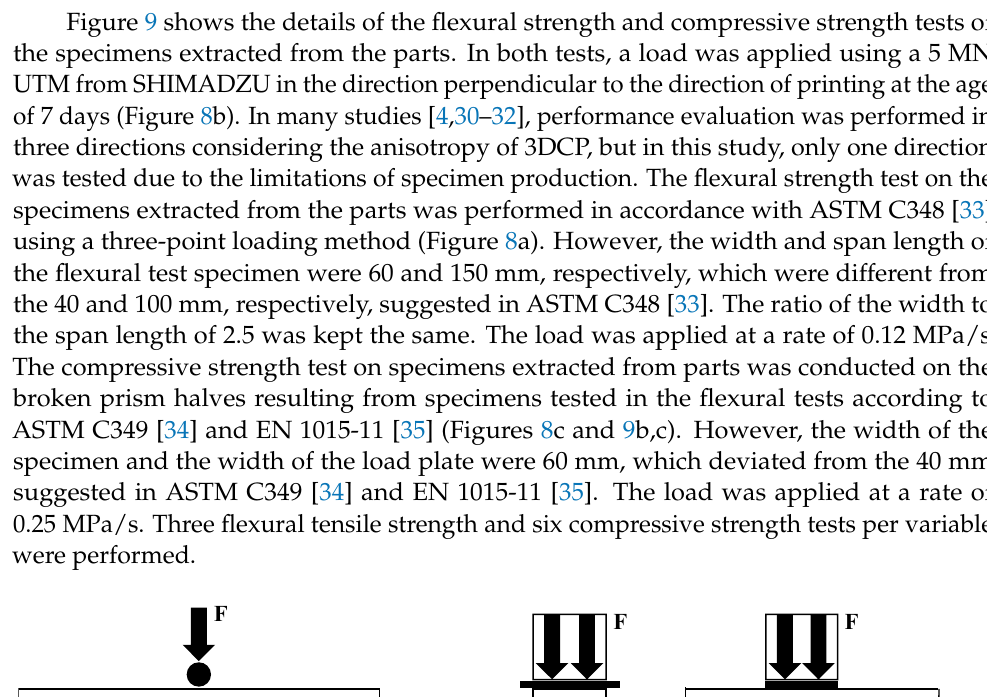
Figure 8. Scenes of mechanical test: ( a ) compressive strength test for 50 by 100 mm cylindrical specimens; ( b ) flexural tensile strength test for specimens cut from parts; ( c ) compressive strength test for specimens cut from parts.